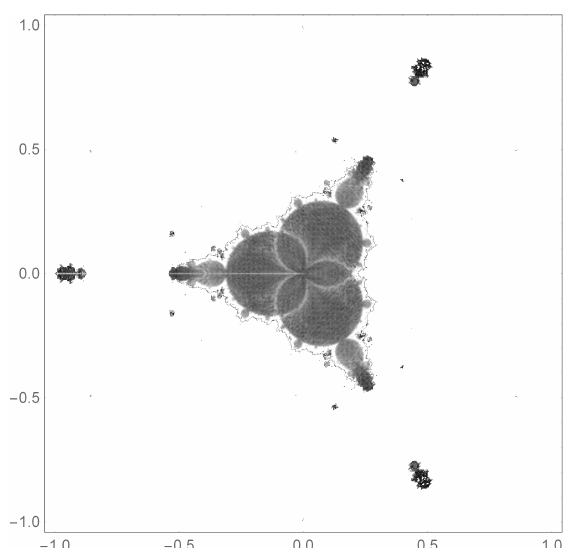
Figure 9. The calculated box dimension of the Julia sets for 400 by 400 lattice points in the window shown. Typical, the values of the dimension (when calculable) range from approximately 1.1 to 1.8. Low values are dark, high values are light and the white background field are areas where the Julia set is too weak to determine a dimension. It is believed that the 3-fold symmetry holds and thus the light line along the negative real axis is an artifact of the way the lattice points aligned with the Julia set itself. Further, the black outline surrounding the main body is believed to be an artifact as well. This is due to the numerical instability of the dimension calculations for these very weak Julia